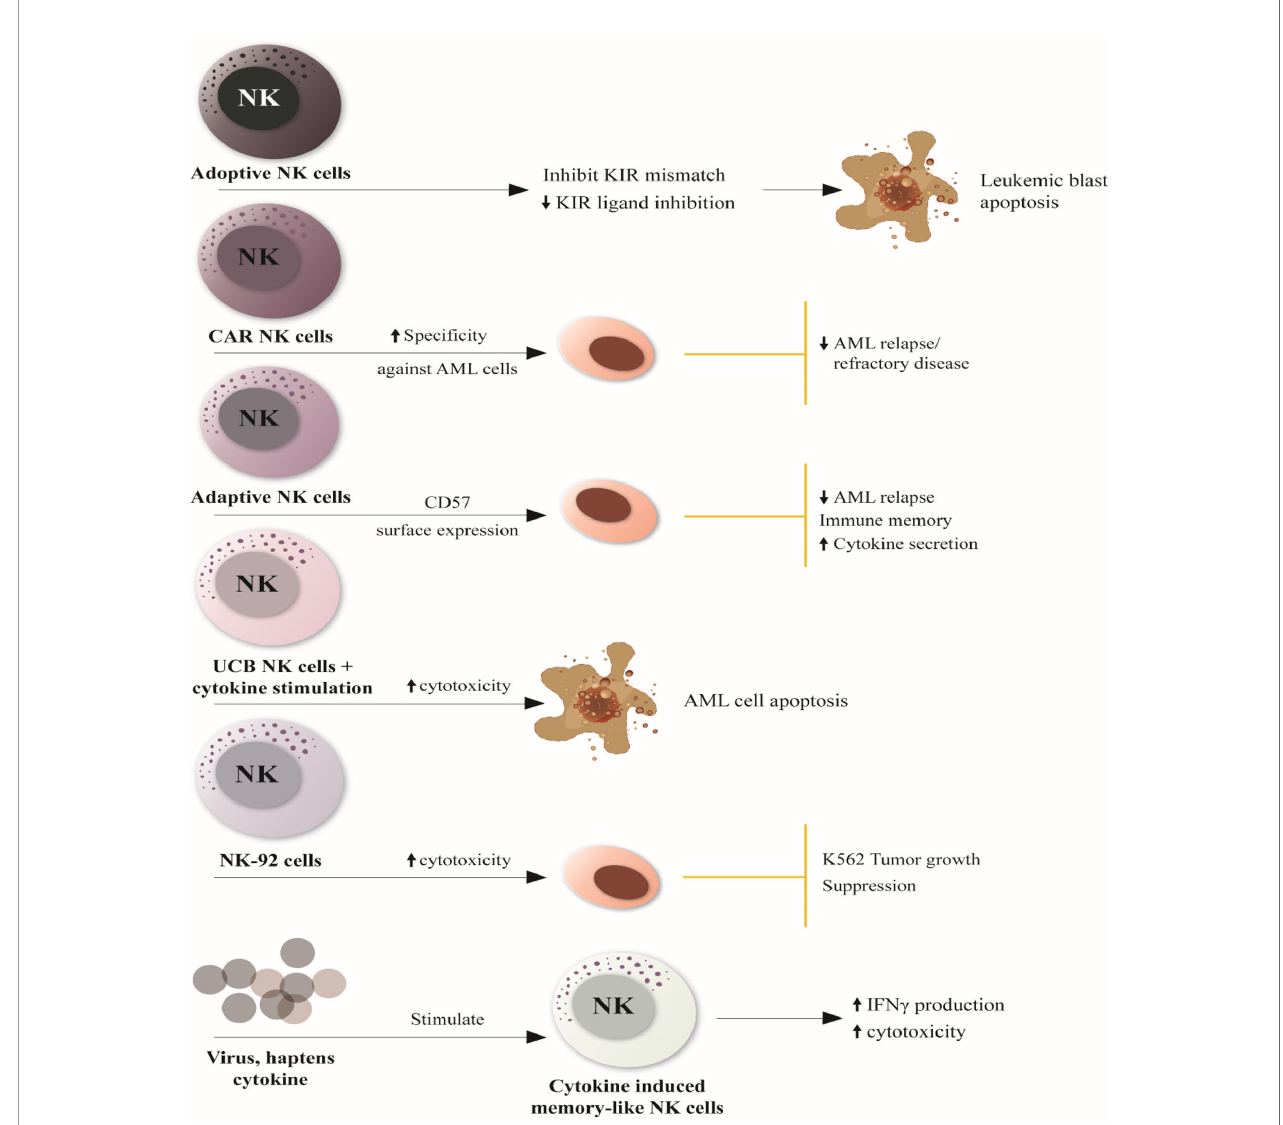
FIGURE 2 | Novel and Improved NK cell-based therapies for AML treatment. 1. Adoptive NK cells can induce leukemic blast apoptosis by inhibiting KIR mismatch and downmodulating KIR ligand inhibitor. 2. CAR NK cells can reduce AML relapse and refractory disease by increasing NK cell speci fi city against antigens expressed on tumor cells 3. Adaptive NK cells restore immune memory and reduce the relapse of AML through the surface expression of the maturation marker CD57 and the activating receptor NKG2C, resulting in enhanced cytokine secretion. 4. UCB NK cells have increased cytotoxicity against AML cells when stimulated by cytokine activity, promoting cancer cell apoptosis. 5. Irradicated NK-92 cells (NK cell lines) induce tumor growth suppression through increased cytotoxic activity. 6. Various viruses, haptens and cytokines can stimulate innate memory or memory-like responses ‘ cytokine-induced memory-like NK cells, ” enhancing interferon- g production and cytotoxicity against leukemia cell lines or primary human AML blasts in vitro . NK, natural killer; KIR, killer Ig-like receptor; CAR, chimeric antigen receptor; CD57, cluster of differentiation 57; UCB-NK cell, umbilical cord blood-Natural killer cells; IFN- g ,